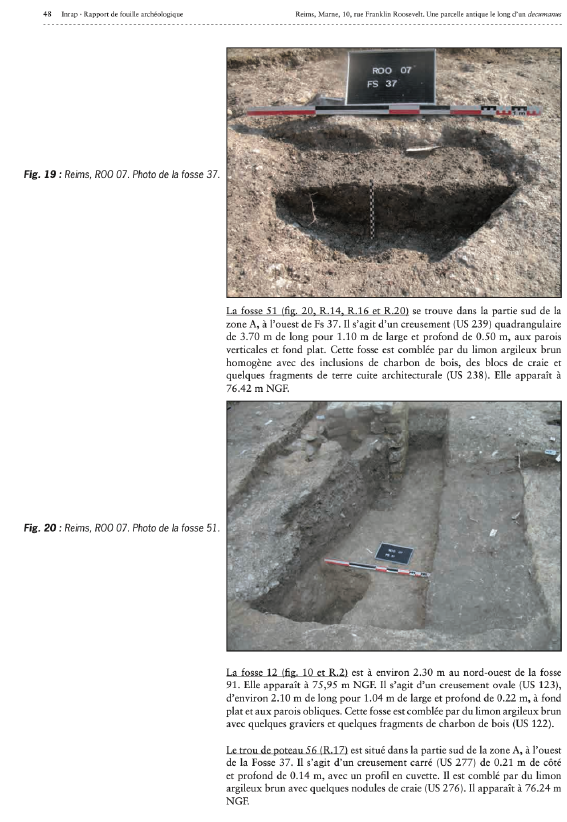
Figure 5 Page of a excavation report with pictures and